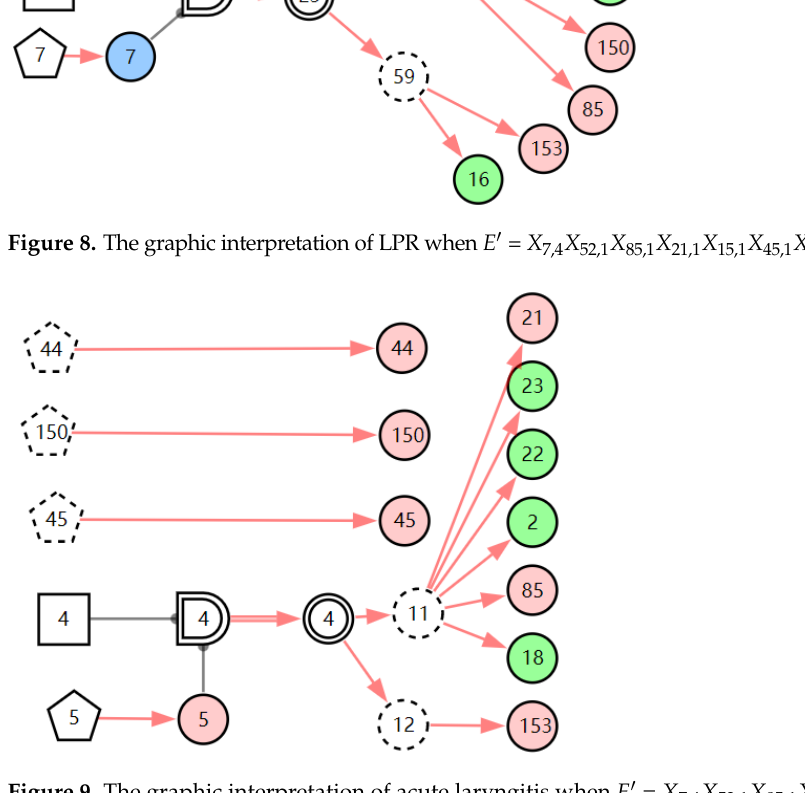
Table 3. The diagnostic result of DUCG basing on the patient’s current symptoms and physical signs.